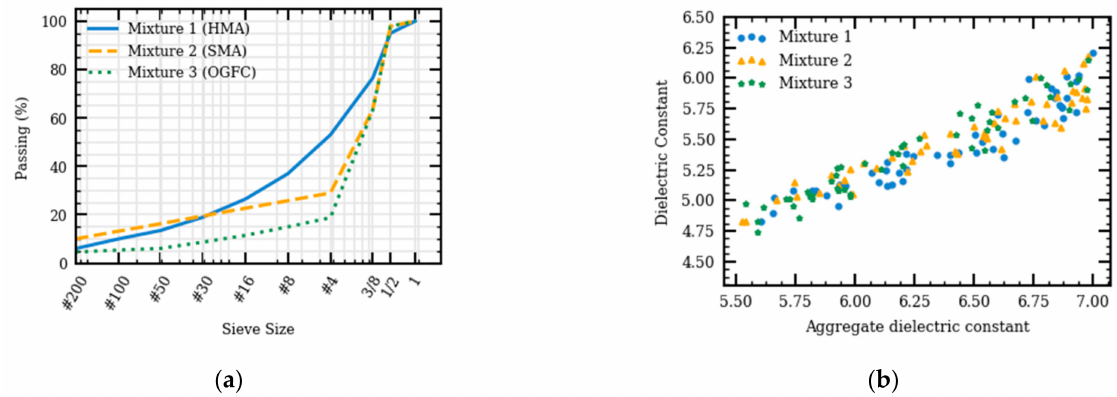
Figure 10. Aggregate gradation for various asphalt concrete (AC) mixtures ( a ) and dielectric constants for various AC mixtures having different aggregate dielectric constants ( b